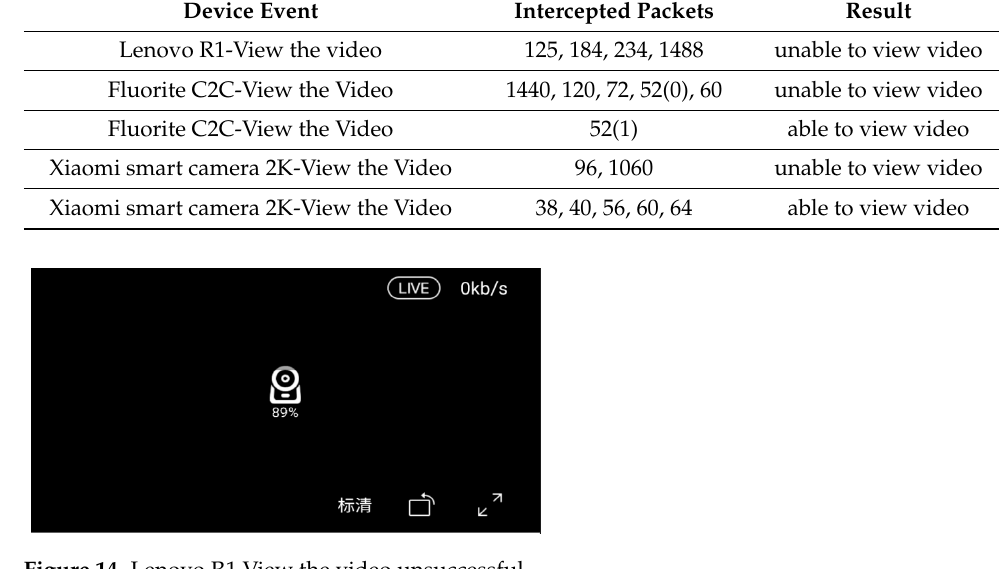
Figure 14. Lenovo R1 View the video unsuccessful.